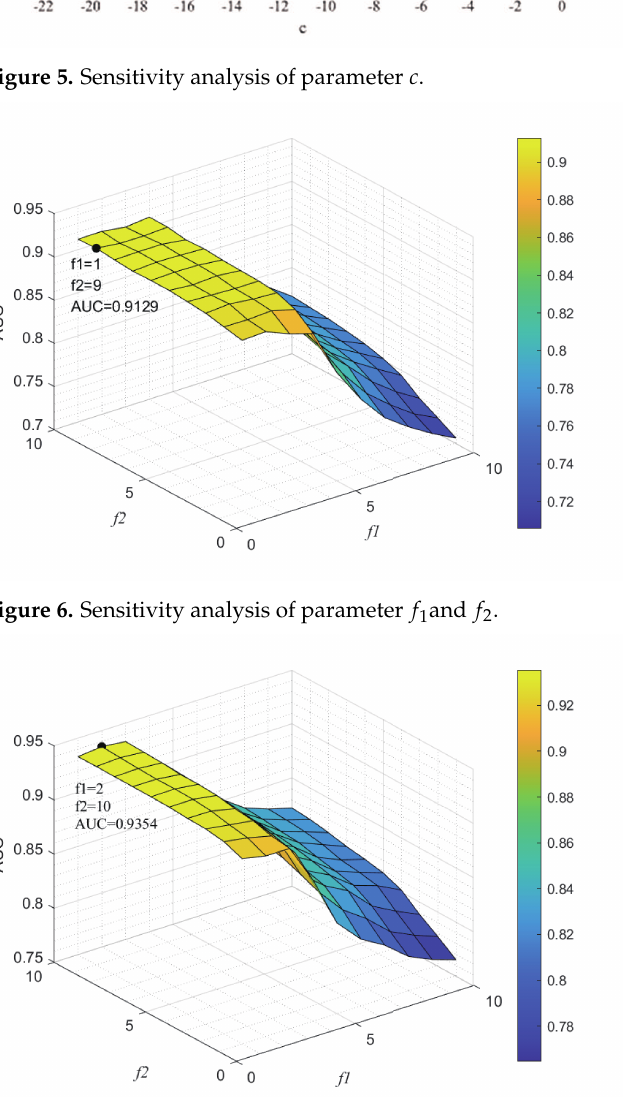
Figure 7. Sensitivity analysis of parameter f 1 and f 2